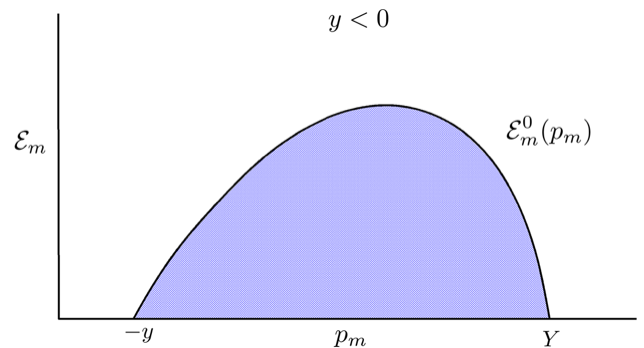
Figure 2. Physically allowed region for the situation where y < 0. The upper boundary labelled E 0 ( p m ) has cos θ m = 0. (The variables employed here are discussed in the text; figure from m